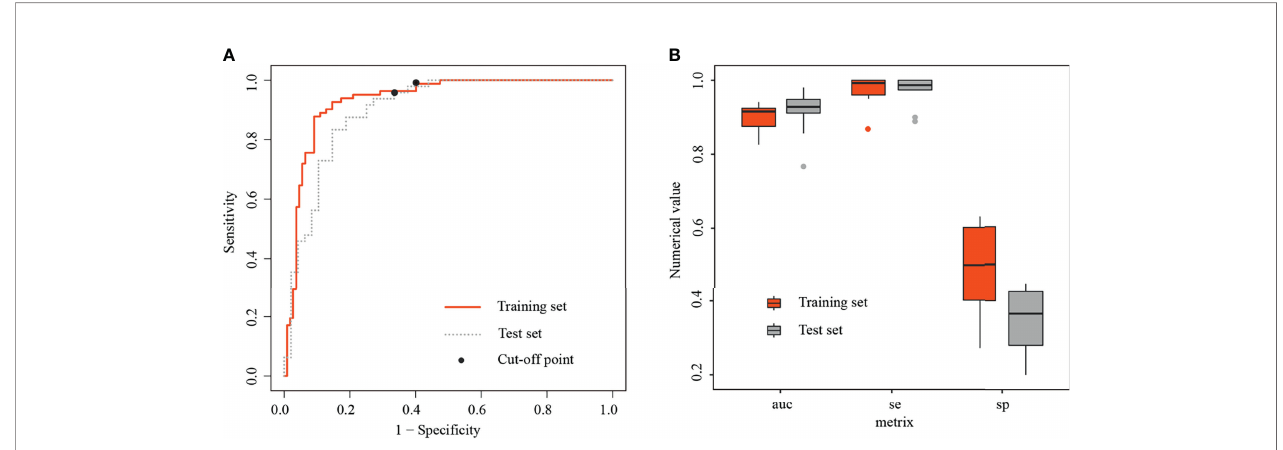
FIGURE 4 | Receiver operating characteristic curves and boxplots in training and test sets. (A) Receiver operating characteristic curves (ROC) in training and test sets, with black dots representing threshold=0.22. (B) Boxplots of area under the curves (AUCs), sensitivities, and speci fi cities generated by fi vefold cross-validation in training and test sets, respectively.